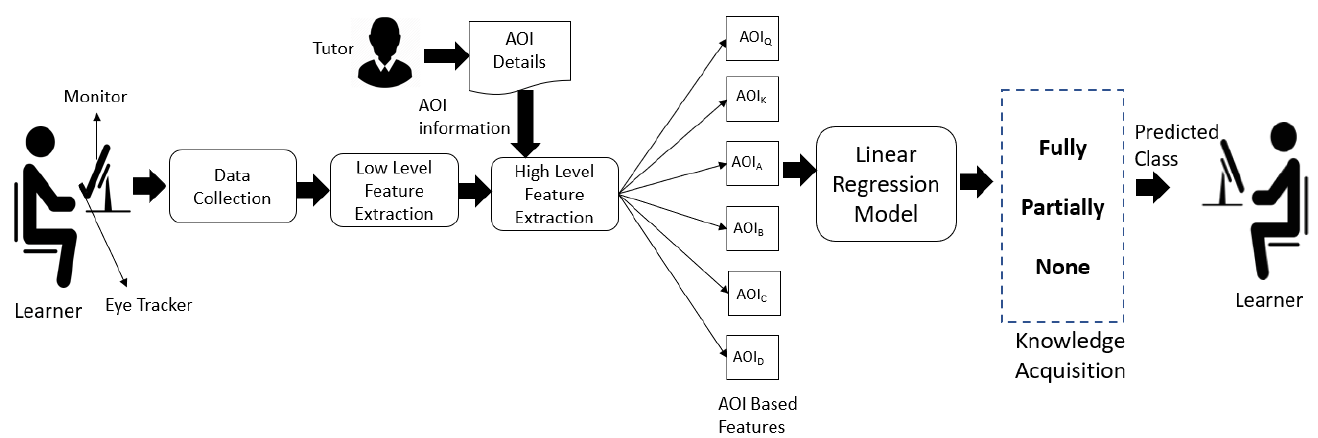
Figure 6. Knowledge Acquisition